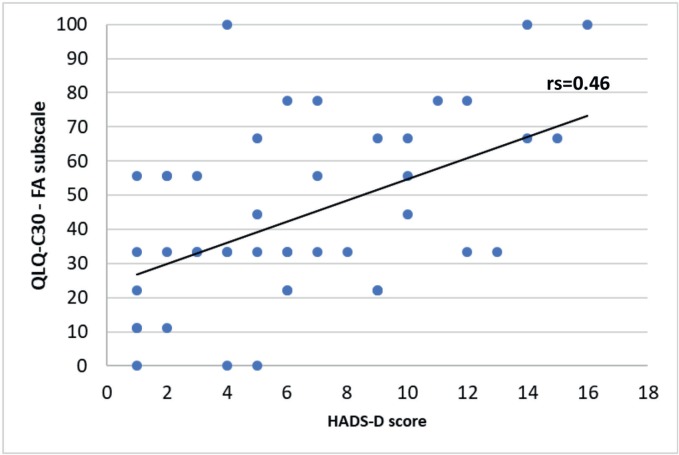
Correlation between HADS-D and the fatigue (FA) subscale of EORTC QLQ-C30.